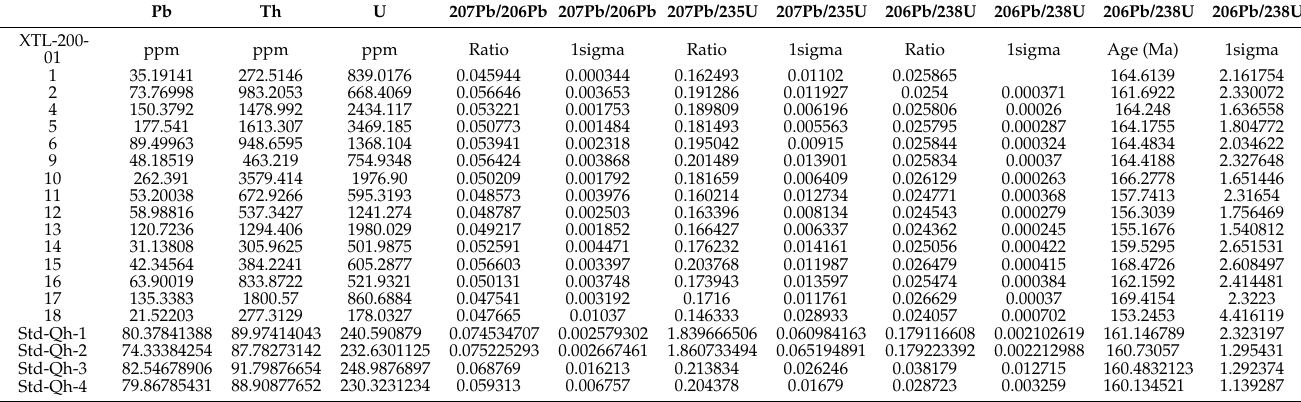
Table 6. LA-ICPMS U–Pb zircon dating data of the XTL200 from the Xintianling deposit.